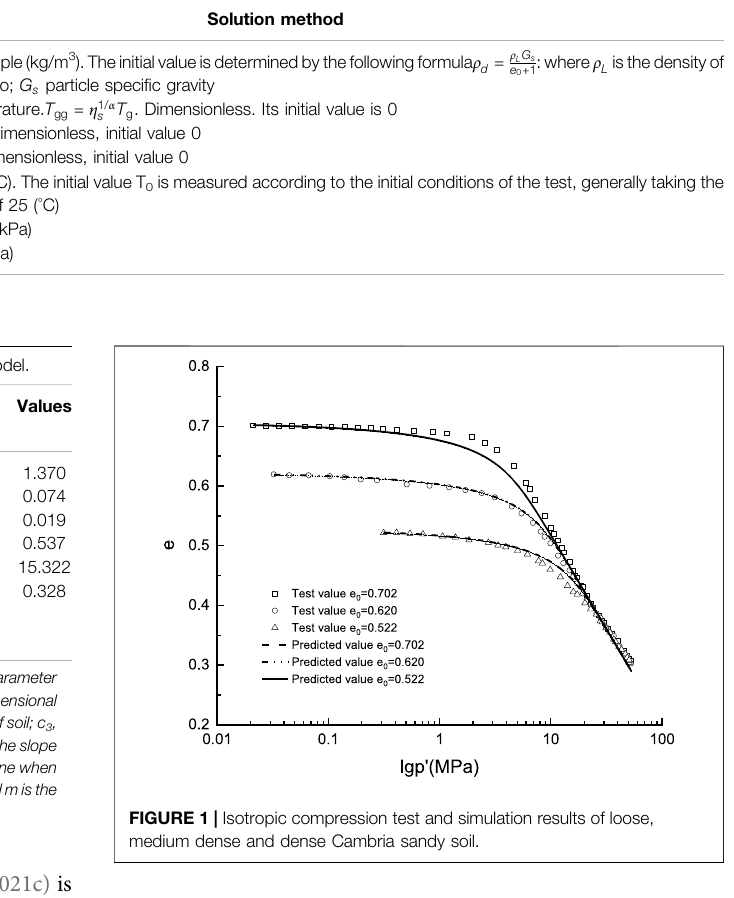
TABLE 1 | State variables in GSH theoretical model.